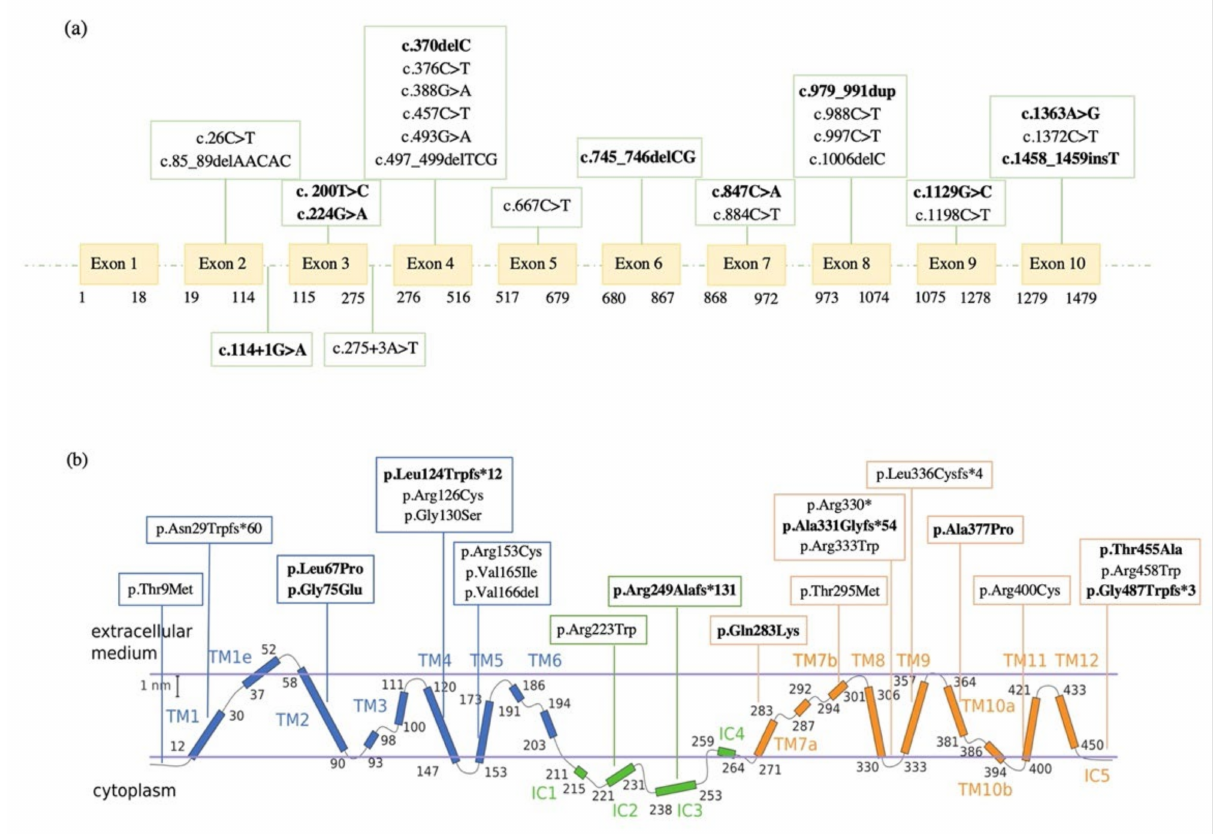
Figure 1. ( a ) Distribution of 25 different variants in the SLC2A1 gene identified in 27 patients with GLUT1DS. ( b ) Representation of the GLUT1 protein domains and mapping of 25 different mutations reported in our GLUT1DS patients (adapted from Galochkina et al., 2019 [23]. More details on licensing are available via the following link http://creativecommons.org/licenses/by/4.0/, accessed on 28 October 2022). Novel variants identified in our cohort are reported in